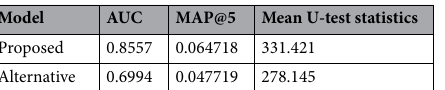
Table 7. Comparisons of the proposed and alternative